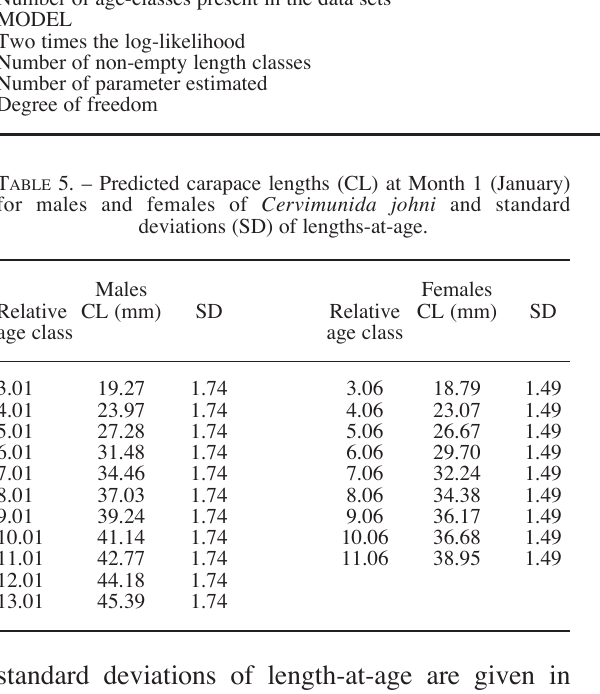
Catch-at-age composition Monthly proportions at relative age classes, as obtained from MULTIFAN, were used to compute ANNUAL GROWTH OF SQUAT LOBSTER OFF NORTHERN CHILE 119